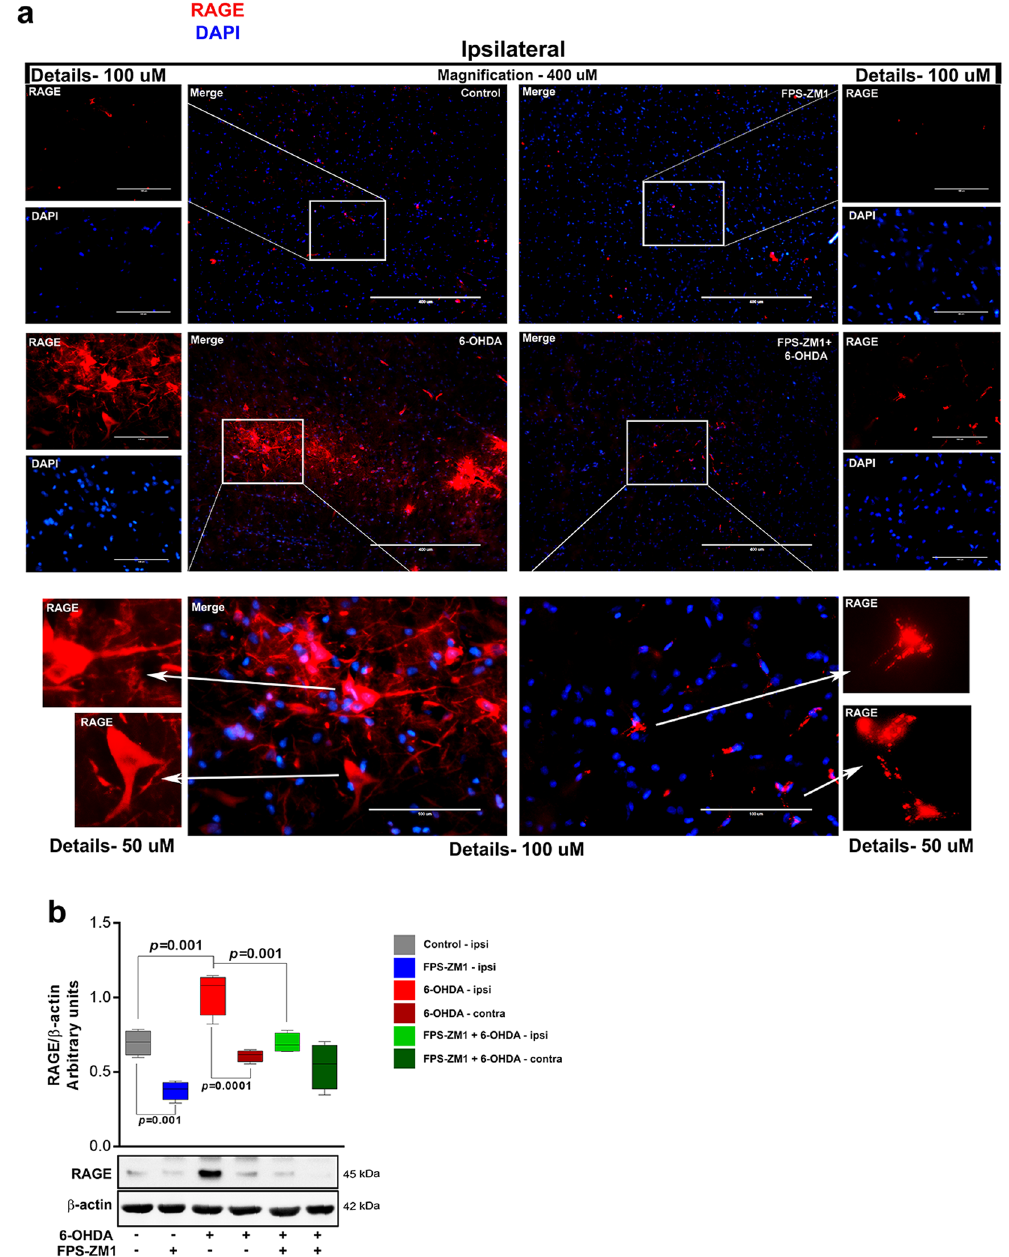
Figure 1. FPS-ZM1 blocked the increase in the levels of RAGE in rats administered with 6-OHDA. Rats were prepared for immunofluorescence and western blotting 15 days after the injection of 6-OHDA. ( a ) Representative immunofluorescence images of SN immunostained for RAGE and DAPI ( n = 10 per group). The ipsilateral sides are shown. The microscopy images were taken with 400 μ m of magnification and the squares represents the location of the approximation of 100 μ m. ( b ) Representative western blots and quantification of RAGE ( n = 6 per group). Each color in the graph represents a group and a brain location: gray - control/ ipsilateral side; blue - FPS-ZM1/ipsilateral side; red - 6-OHDA/ipsilateral side; dark red - 6-OHDA/contralateral side; green - FPS-ZM1 + 6-OHDA/ipsilateral side; dark green - FPS-ZM1 + 6-OHDA/contralateral side. Values represent mean ± SD. One-way analysis of variance and Bonferroni Multiple Comparison post-hoc test were applied to all data. p values are embedded in the